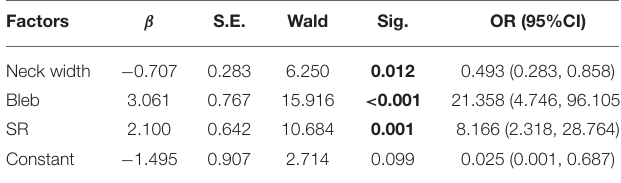
TABLE 2 | The multivariate logistic regression analysis of factors associated with rupture of the aneurysm. Factors